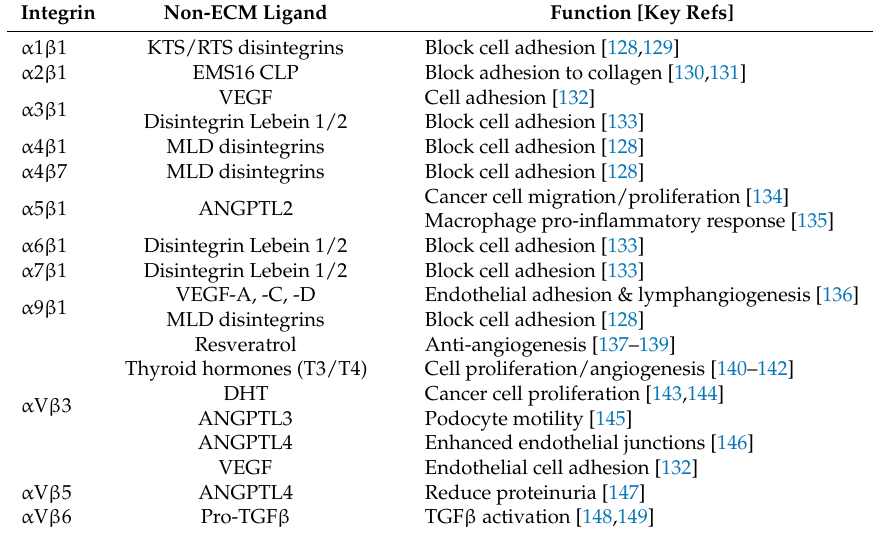
Table 3. Integrin binding by small molecules, hormones, growth factors, and